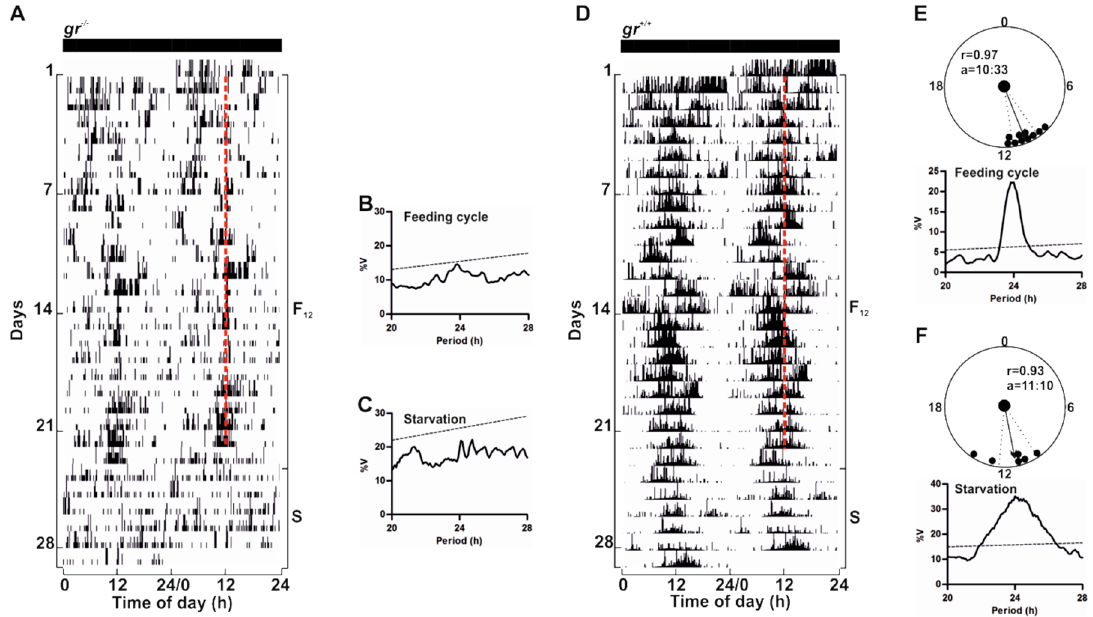
Figure 10. Behavioural entrainment by periodic food availability of gr +/+ and gr − / − adult zebrafish. Representative actograms ( A , D ), χ 2 periodogram analysis and circular diagrams ( B , C , E , F ) of adult zebrafish gr +/+ and gr − / − maintained under constant darkness and fed once a day at a fixed time (12:00). Starting and ending day of each feeding cycle (F 12 ) and starvation (S) is shown on the right of the actogram. The number of days is indicated on the left and the time of day is plotted on the bottom of each actogram. Red dotted lines indicate the time of feeding. Circular diagrams showing acrophases for F 12 and S period are plotted ( E , F ). Activity records of each F 12 or S cycle were subjected to χ 2 periodogram analysis ( B , C , E , F ). For more details see Figure